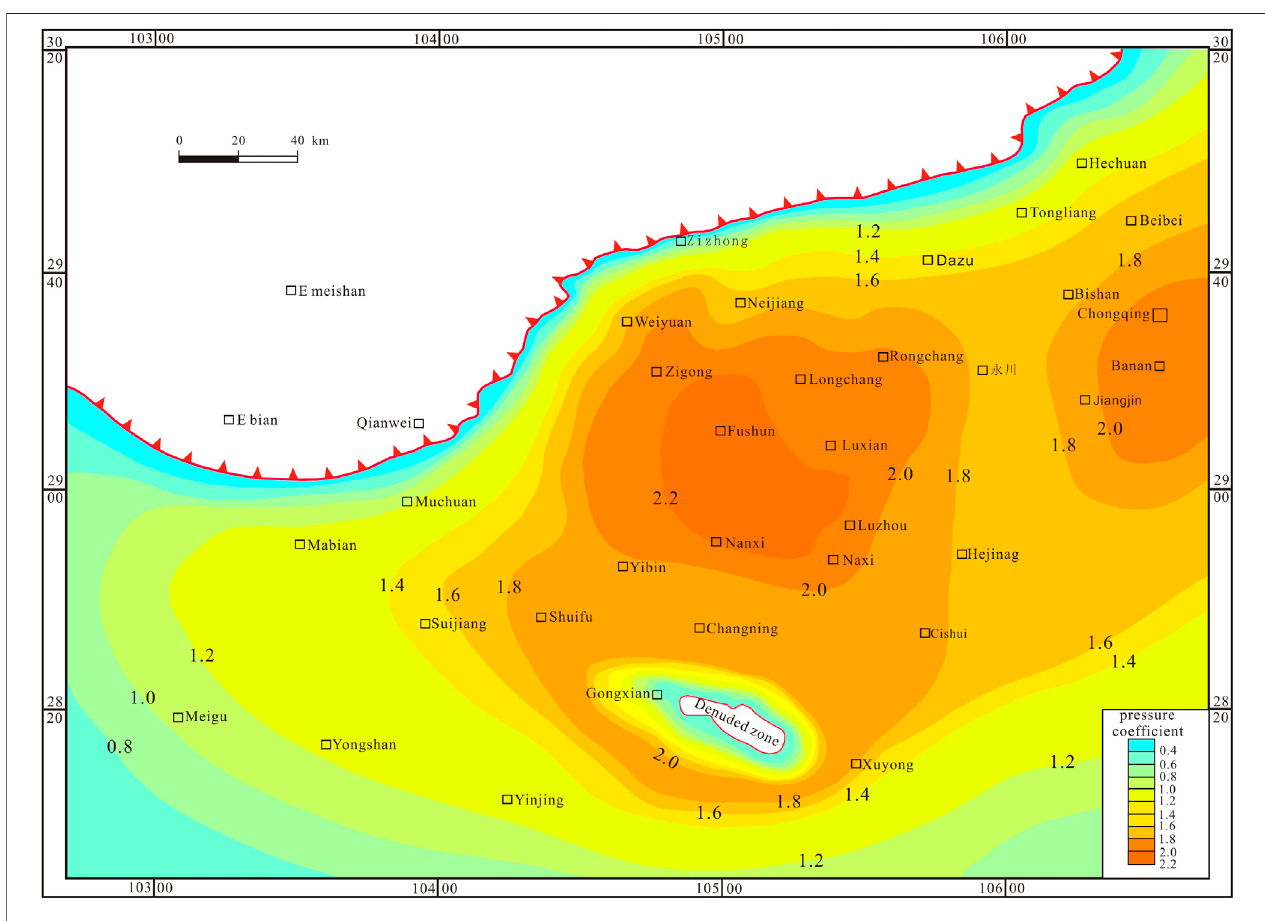
FIGURE 12 | Distribution of formation pressure coef fi cients of the Wufeng-Longmaxi Formation in southern Sichuan.